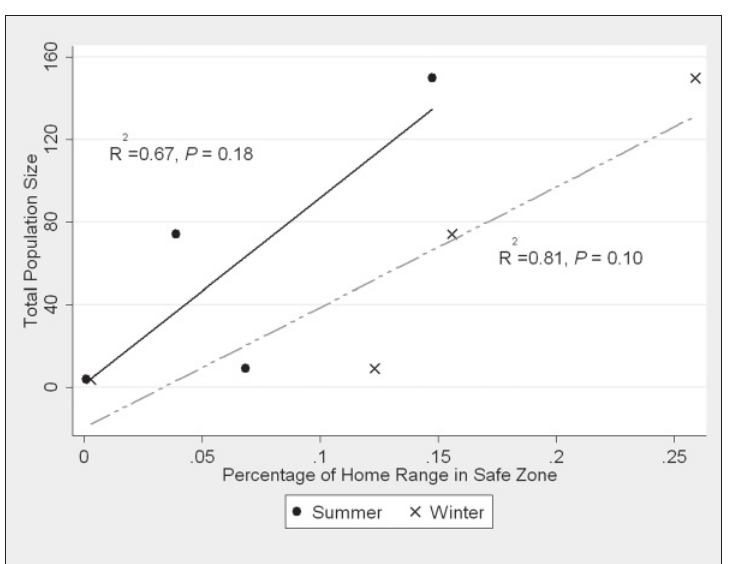
Fig. 3. Habitat-population relationships between percentage of home range con- sisting of safe zone within each caribou herd, and estimated population size of the caribou herd during winter and